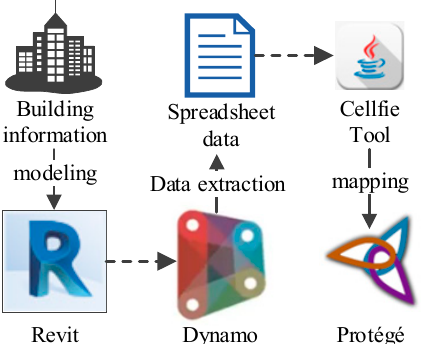
Figure 4. Implementation path of data interoperability.